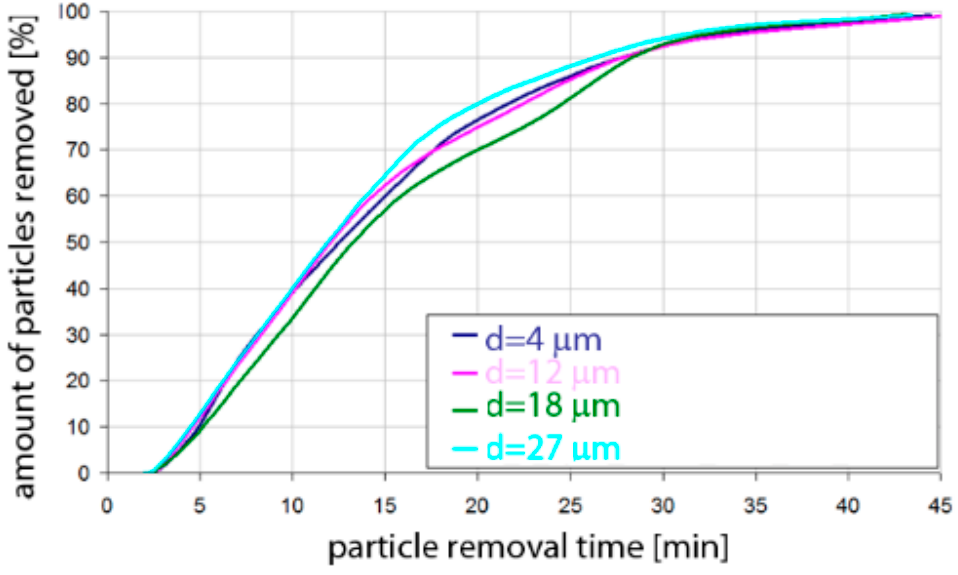
Figure 19. Share of removed non-metallic Al 2 O 3 inclusions from the analysed ladle in the case of argon flow of 25 L/min through the 42CrMo4 steel.